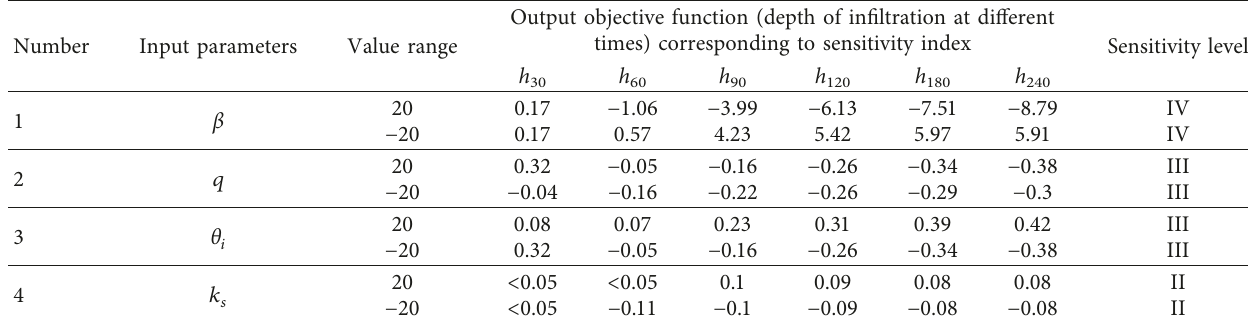
Table 4: Sensitivity analysis of rainfall infiltration